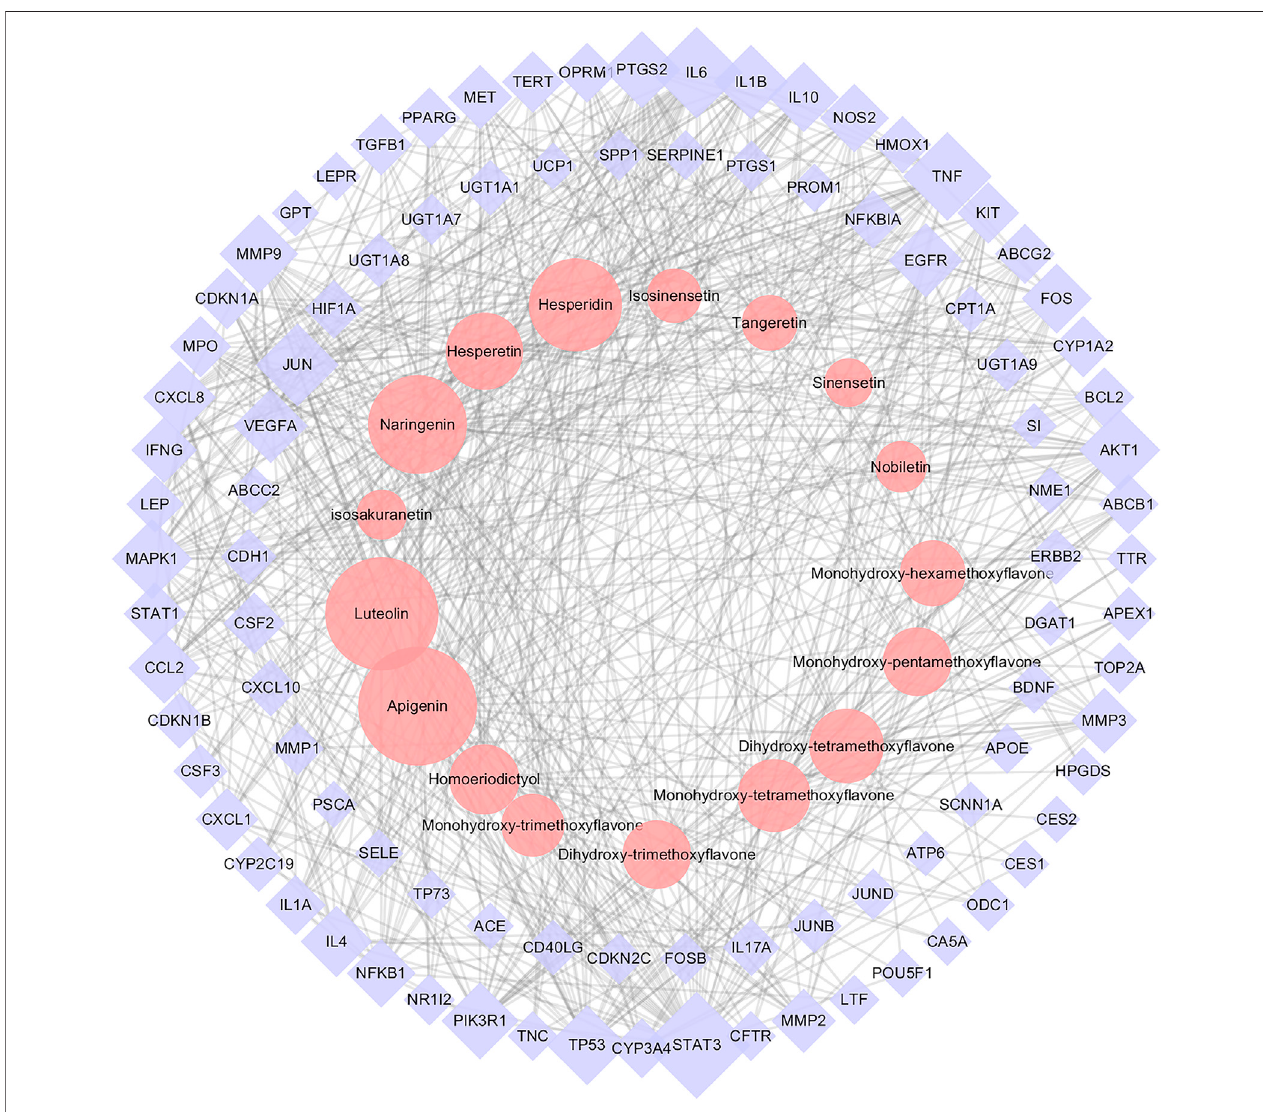
FIGURE 7 | The Citri Reticulatae Pericarpium (CRP)-related target-spleen de fi ciency target network (CT-ST network). Pink circles, purple diamonds represented CRP compounds and the common targets for both compounds and spleen de fi ciency, respectively. The size of circles and diamonds indicated nodes degree value.